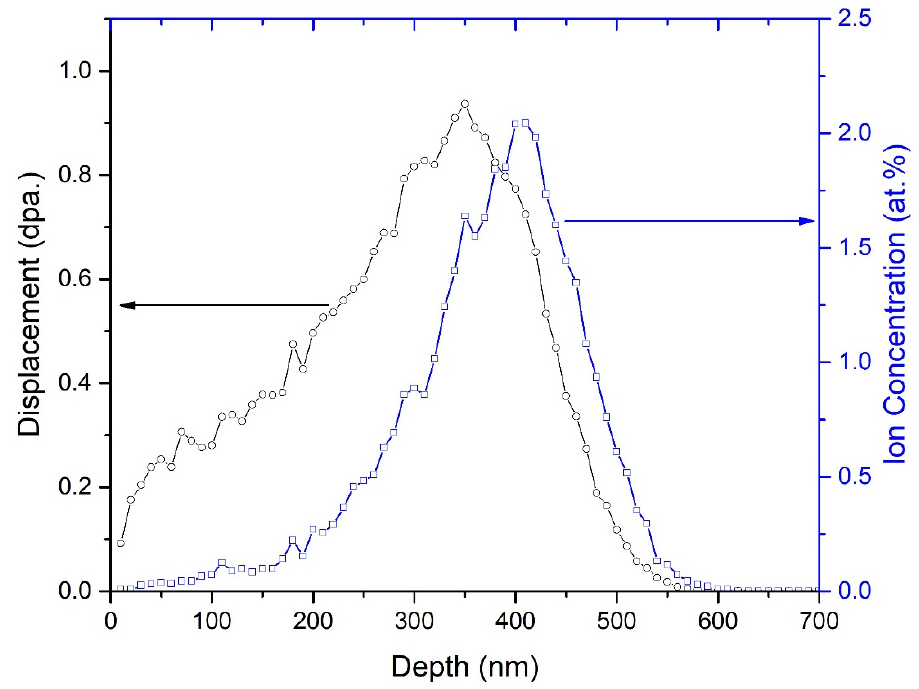
Figure 2. SRIM simulation results of displacement damage and He + ion concentration as a function of depth for 50 keV He + ion irradiation in GC1 to a fluence of 2.6 × 10 16 He + /cm 2 .